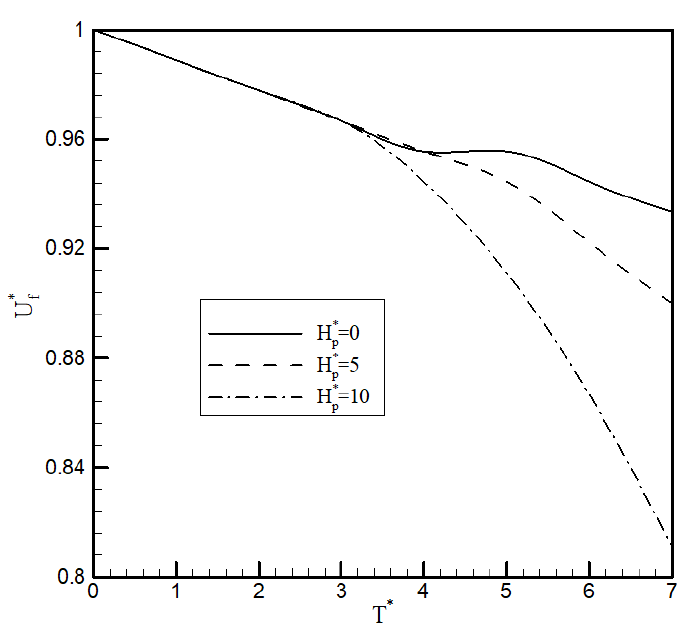
Figure 4. The effect of the tip propulsor thrust and angular momentum on the flutter speed of the wing (case 1).